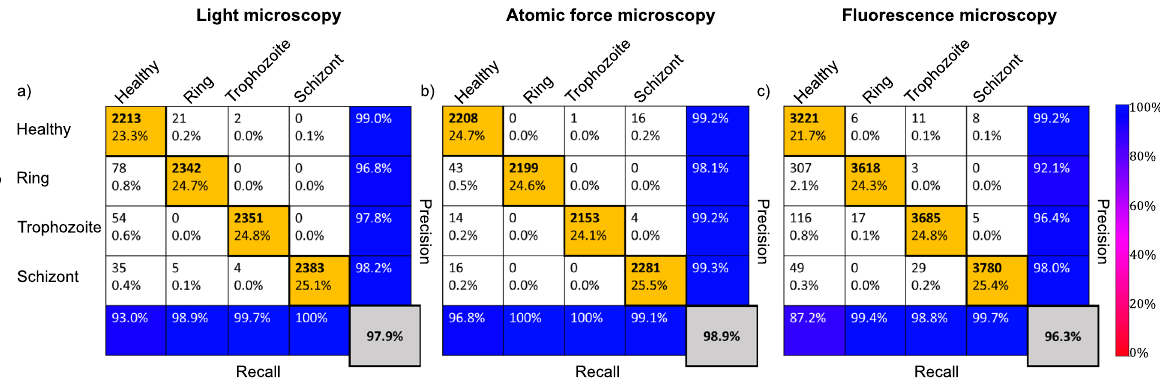
Figure 6. Classification performance of the convolutional NN on two orthogonal 1D cross-sections. The performance parameters for light microscopy, AFM and fluorescence microscopy, as obtained using two perpendicular cuts of single-RBC images, are respectively summarised in the confusion matrices of panels ( a ), ( b ) and ( c ). For the description of these perpendicular cross-sections, the asymmetric and the 90 the main text. Notations, labels and colours follow the same convention as in Fig. 4. For the classification here, the balanced (augmented) image sets were used, as in Fig. 4d–f. The overall classification accuracy is highly improved with respect to the classification using the 2D images and reaches more than 96% for each microscopy technique: 97.9% for light microscopy, 98.9% for AFM, and 96.3% for fluorescence microscopy.